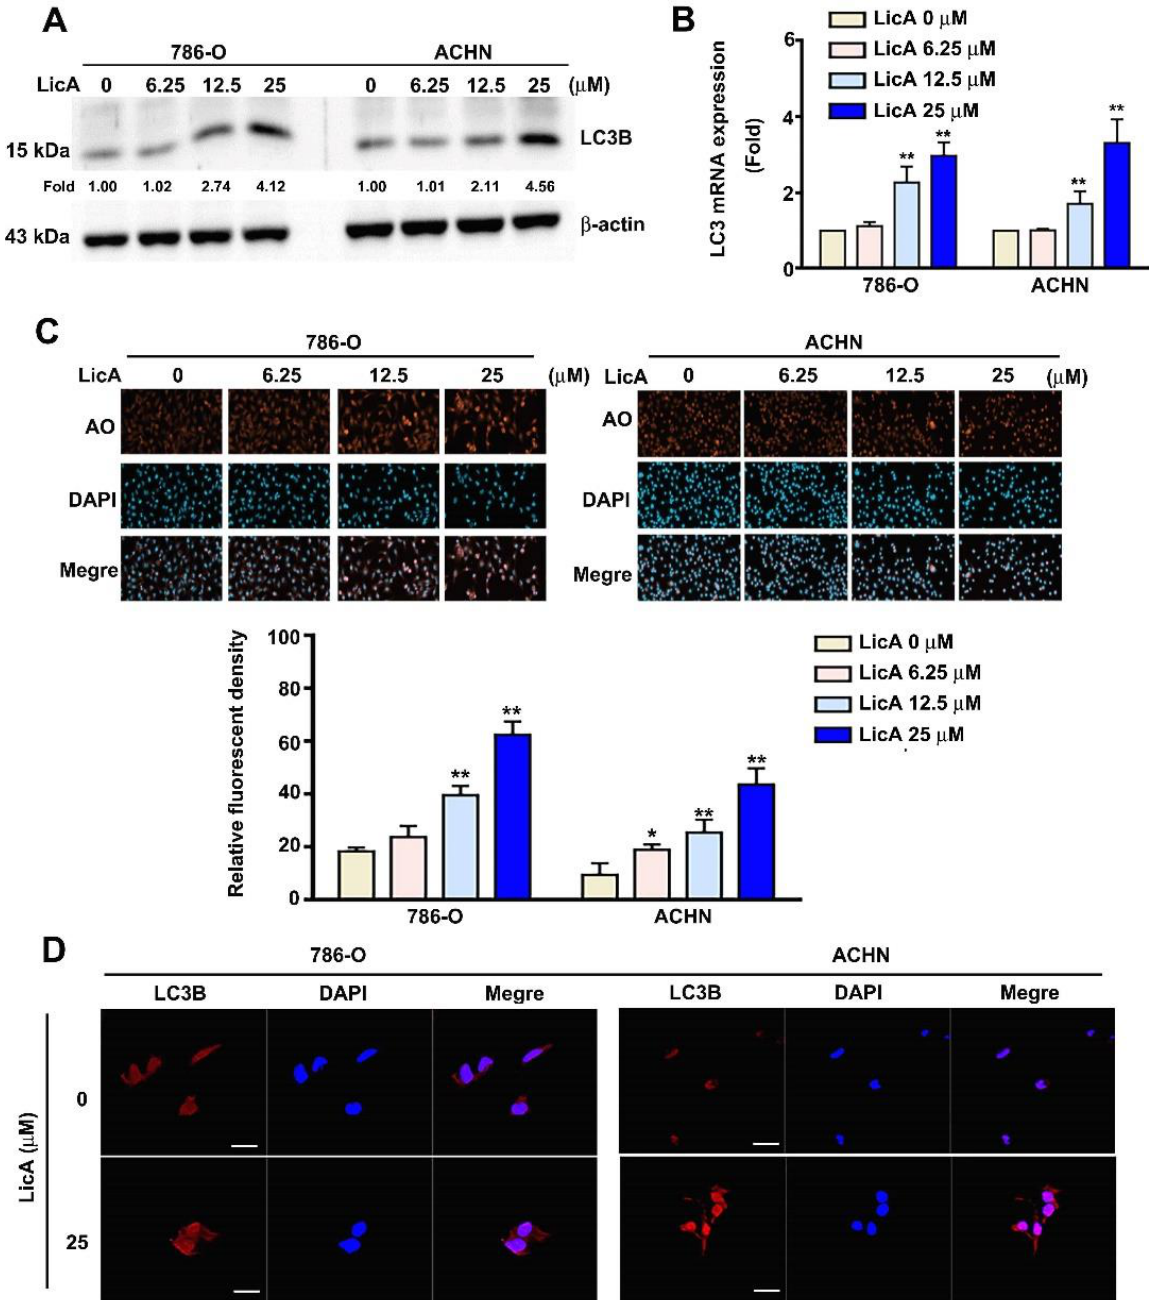
Figure 3. The effects of LicA on the expression of LC3B and autophagy in RCC cells. LicA was applied to 786-O and ACHN cells in a range of concentrations (0, 6.25, 12.5, and 25 µ M). ( A ) Western blotting was utilized to detect LC3B in total protein lysates from treated cells, with β -actin serving as a loading control. ( B ) Total RNA was extracted from the cells treated with LicA and subjected to RT-PCR. ( C ) Using the relative fluorescence intensity of the AO (red) and DAPI reagents as counterstains, the effects of LicA on autophagy were measured. AO cell quantification was evaluated using flow cytometry. ( D ) The cell nuclei were counterstained with DAPI solution after the cells had been fixed and immunostained with antiLC3B antibody (red). The data represent the mean ± SD of at least three separate experiments. * p < 0.05, ** p < 0.01, compared to untreated control (0 µ M). Scale bar = 50 µm.